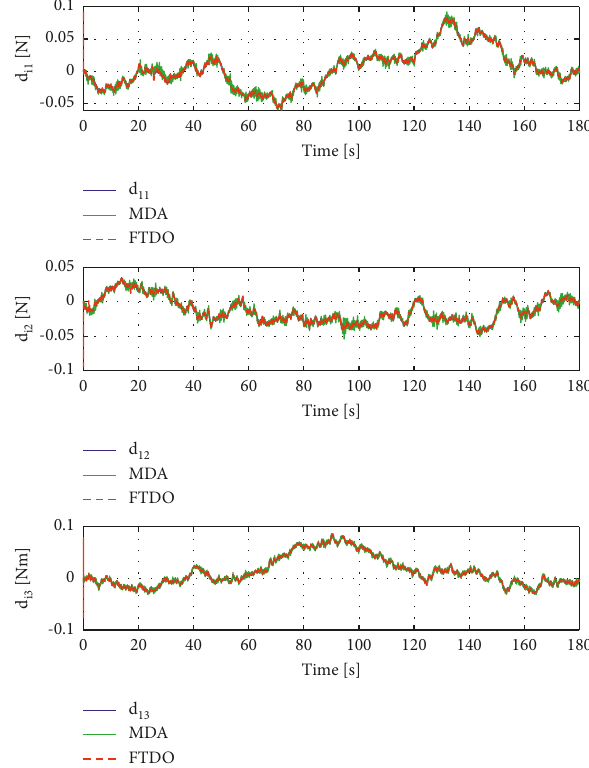
Figure 7: The time-varying environmental disturbance estimation of the 1th USV.